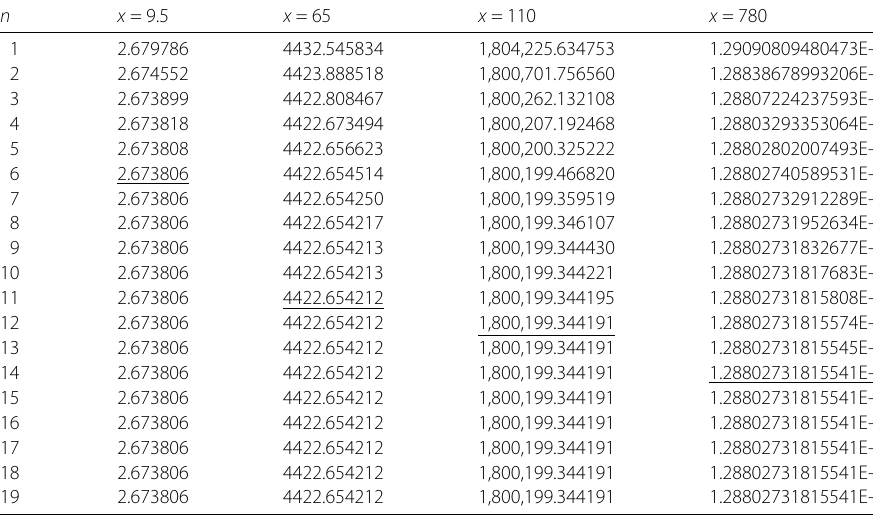
Table 1 Some numerical results for calculation of Γ q ( x ) with q = 1 x = 9.5,65,110,780 in Algorithm 2